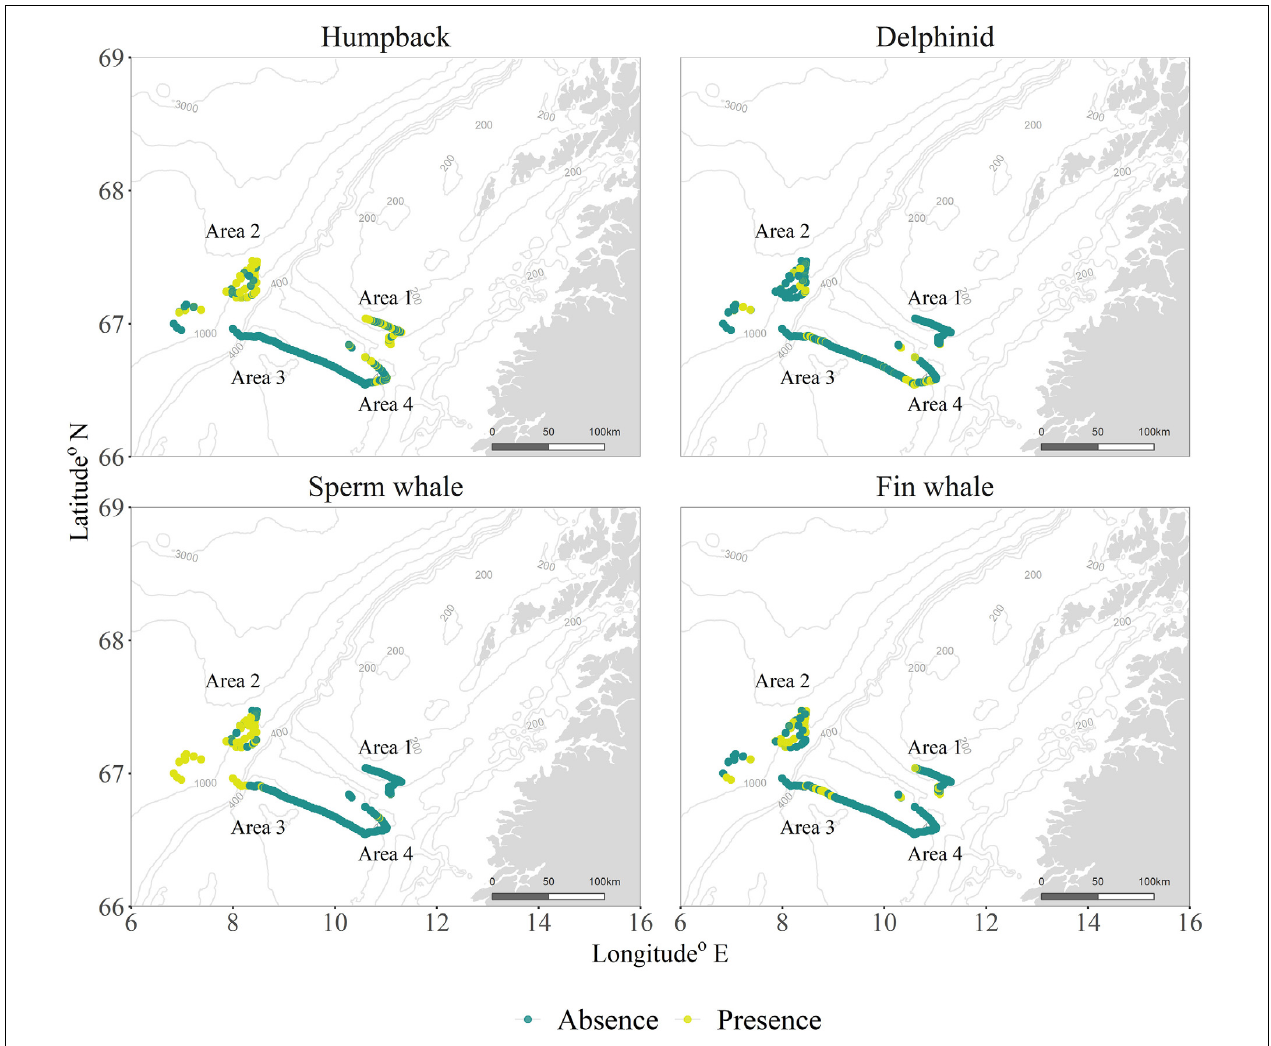
FIGURE 1 | Marine mammal detections (described as presence/absence) per area